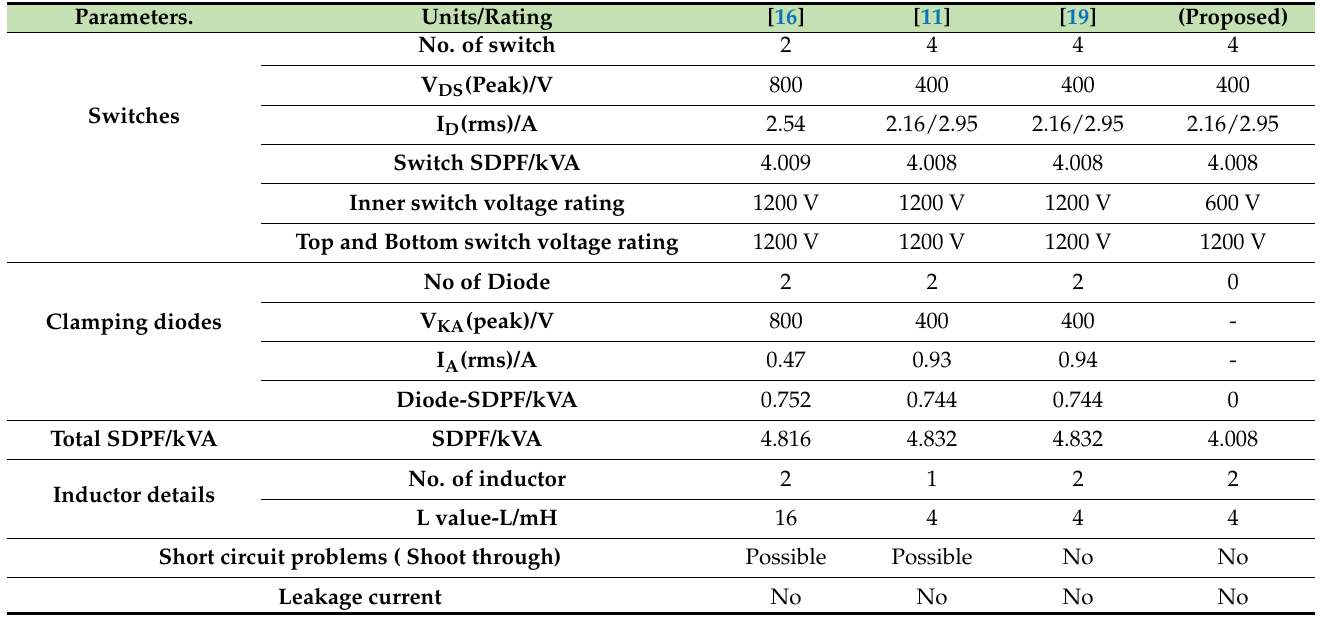
Table 5. Comparison of proposed inverter with existing inverter